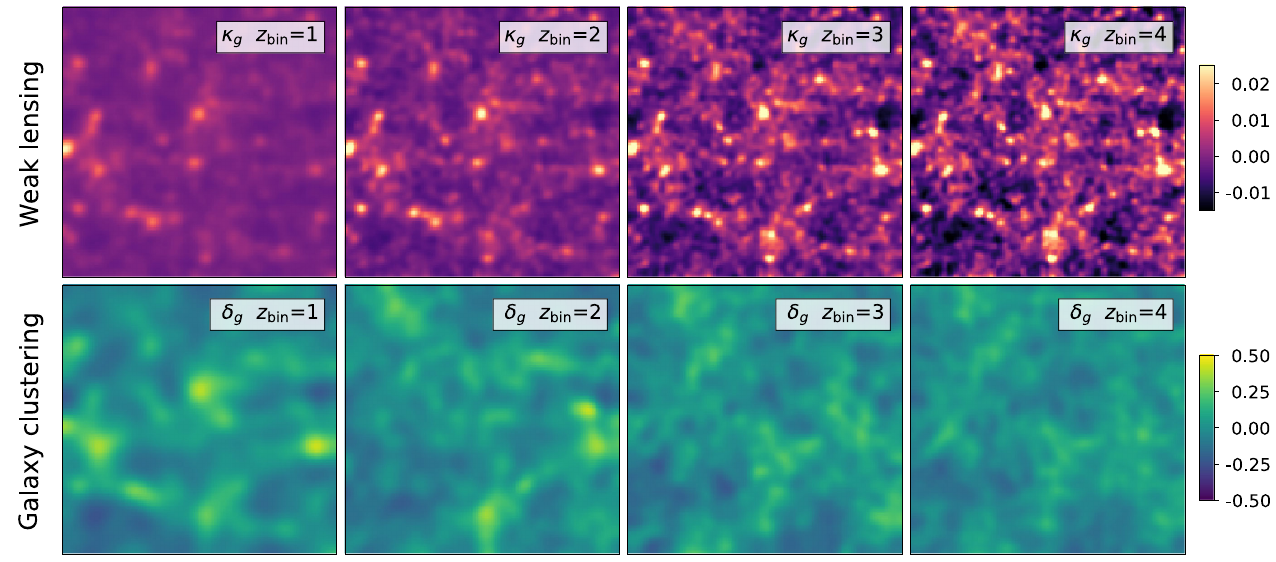
and galaxy clustering δ , before the addition of noise. The size of the maps is m m